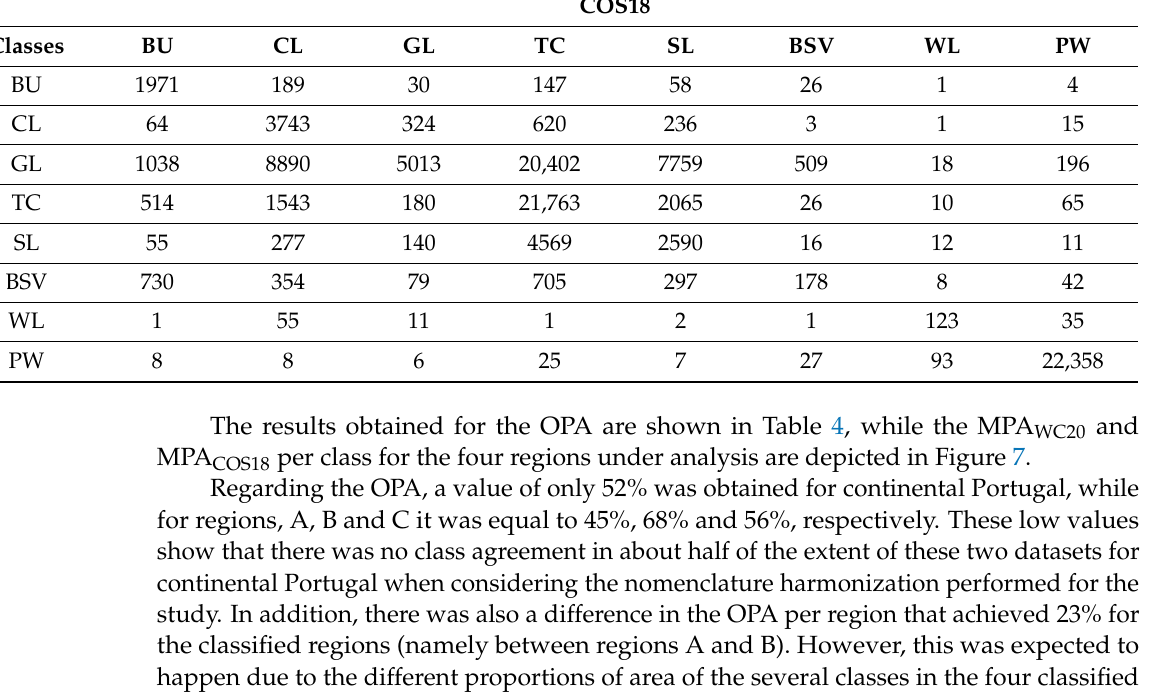
Table 3. Cross-tabulation matrix obtained for continental Portugal. The p ij values in the cells represent the area, in km 2 , of class i in WC20 and class j in COS18. COS18